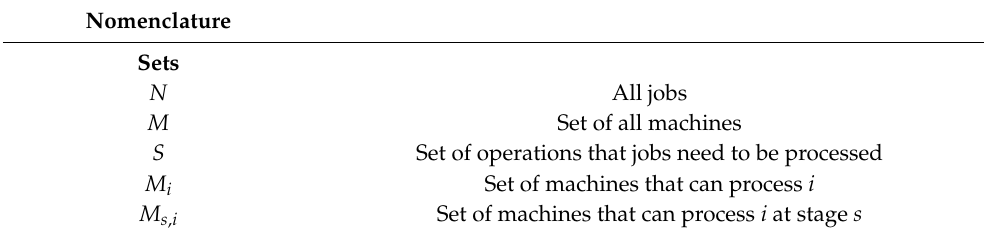
Table 1. Symbol description.